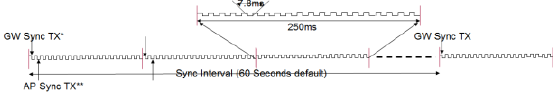
Figure 2. Time slot in RapidNet IP